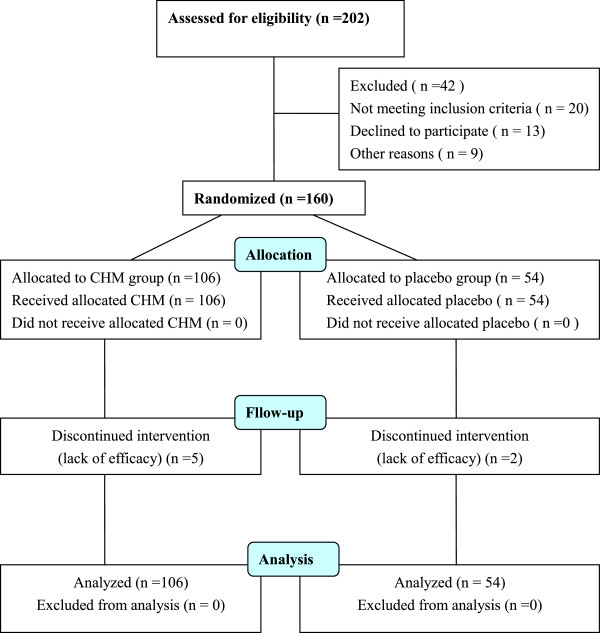
The flow of participants in the study.